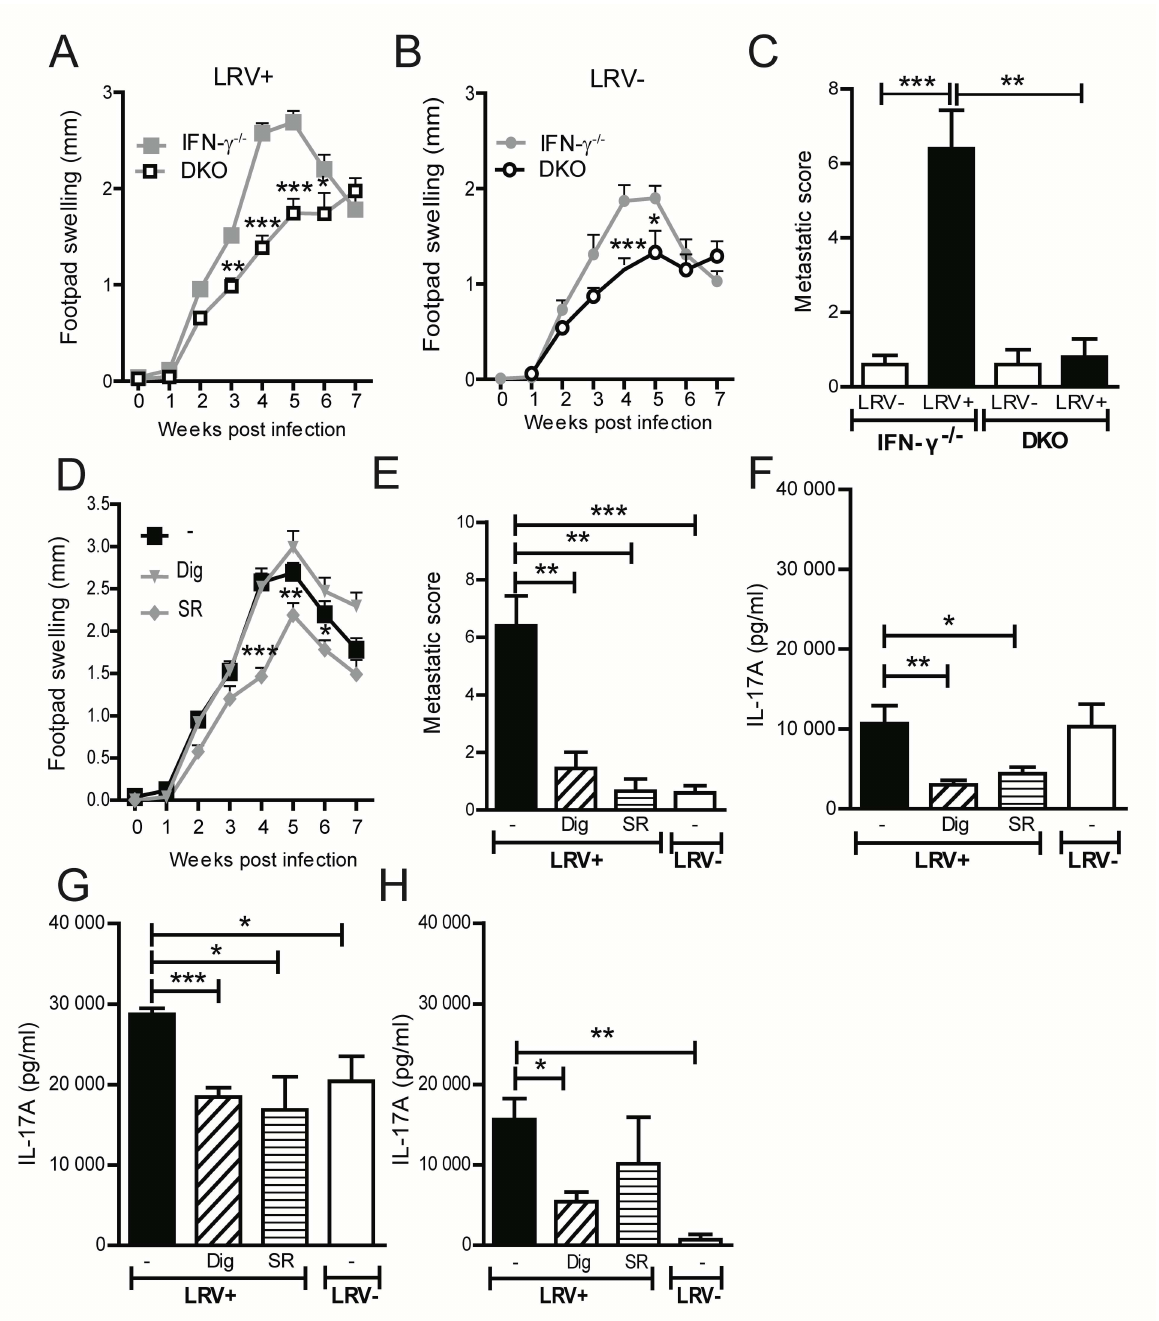
Fig 4. IL-17AmediatesLRV1-dependent metastasis. (A-C) Mice deficientin IFN- γ -/- or IFN- γ -/- IL-17A -/- (DKO) were infected in footpads with either (A) LRV1+ or (B) LRV1- L . g promastigotes. Footpad swelling was measuredweekly. (C) The numberof secondary lesions was countedin all groups at 7 weeks post infection. (D-H) IFN- γ -/- mice were infected in their footpads with LRV1+/- L . g parasites. At the onset of visible lesions (2.5 weeks post infection) IFN- γ -/- mice were treatedi.p with eitherone of the IL-17Ainhibitors every 2 days, namelyDigoxin (Dig)or SR1001(SR). (D) The change in footpad swelling was measuredweekly. (E) At 7 weeks post infection, the numberof secondary lesions was countedin all groups of treatedmice. (F) At week 4 post infection, popliteallymph node cells frommice presentedin (D) ,were restimulated for 72h invitro with UV inactivated L . g parasites. IL-17Aproductionin culture supernatants was measuredby ELISA. After7 weeks, lymphocytes from (G) poplitealand (H) iliac lymph nodes were also restimulated in vitro in orderto quantifyIL-17Aproductionby ELISA. Graphs are representative of a minimumof 2 independent experiments, using at least 5 mice per conditionand represented as mean ± SEM. Significance is tested by one-way Anova (diseasescore)or an unpaired,parametric t -test(bar graphs)and indicatedas * : P < 0.05, ** P < 0.005, *** P <